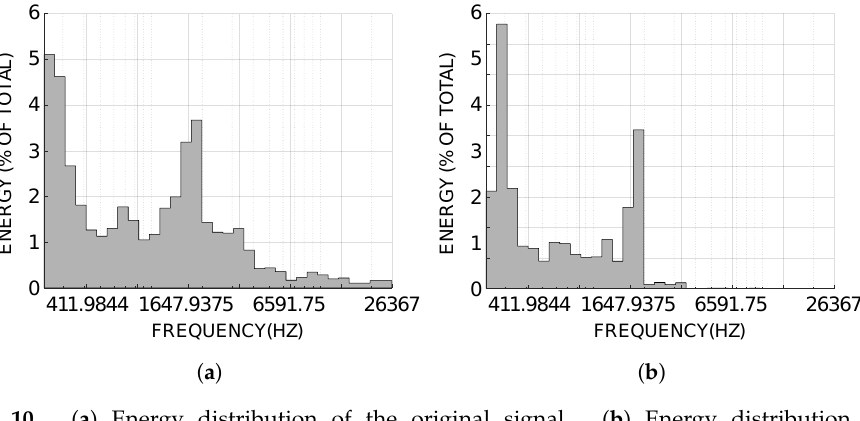
Figure 10. ( a ) Energy distribution of the original signal. ( b ) Energy distribution of the high-resonance